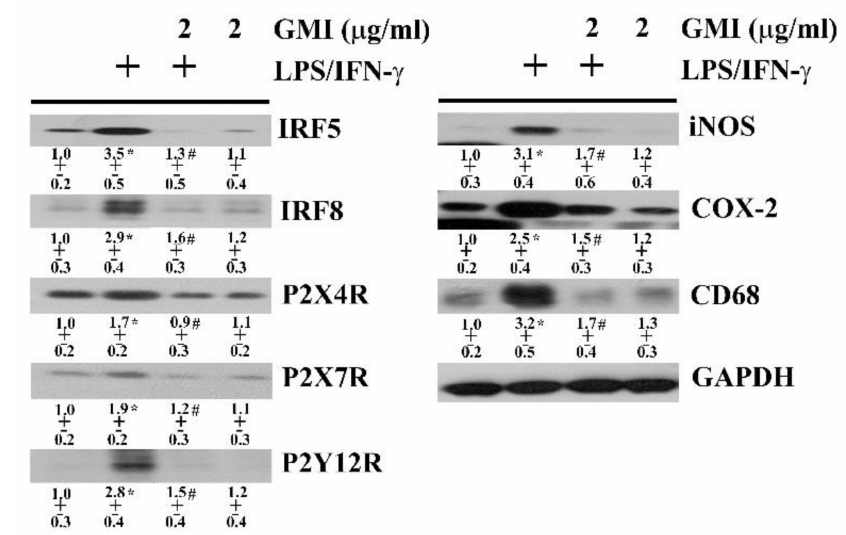
Figure 7. GMI alleviated microglial activation. Neuron/glia cultures were pretreated with vehicle or various concentrations of GMI (0.1 and 2 µ g/mL) for 30 min before being incubated with LPS (100 ng/mL)/IFN- γ (10 U/mL) for an additional 24 h. Total cellular proteins were extracted and subjected to Western blot analysis with indicated antibodies. One representative blot of four independent culture batches is shown and the fold of relative protein content is depicted under the blots. The protein content of untreated control was defined as 1.0. The + means the groups treated with LPS/IFN- γ and the rest groups without + indicate vehicle treatment. * p < 0.05 vs. untreated control and # p < 0.05 vs. LPS/IFN- γ